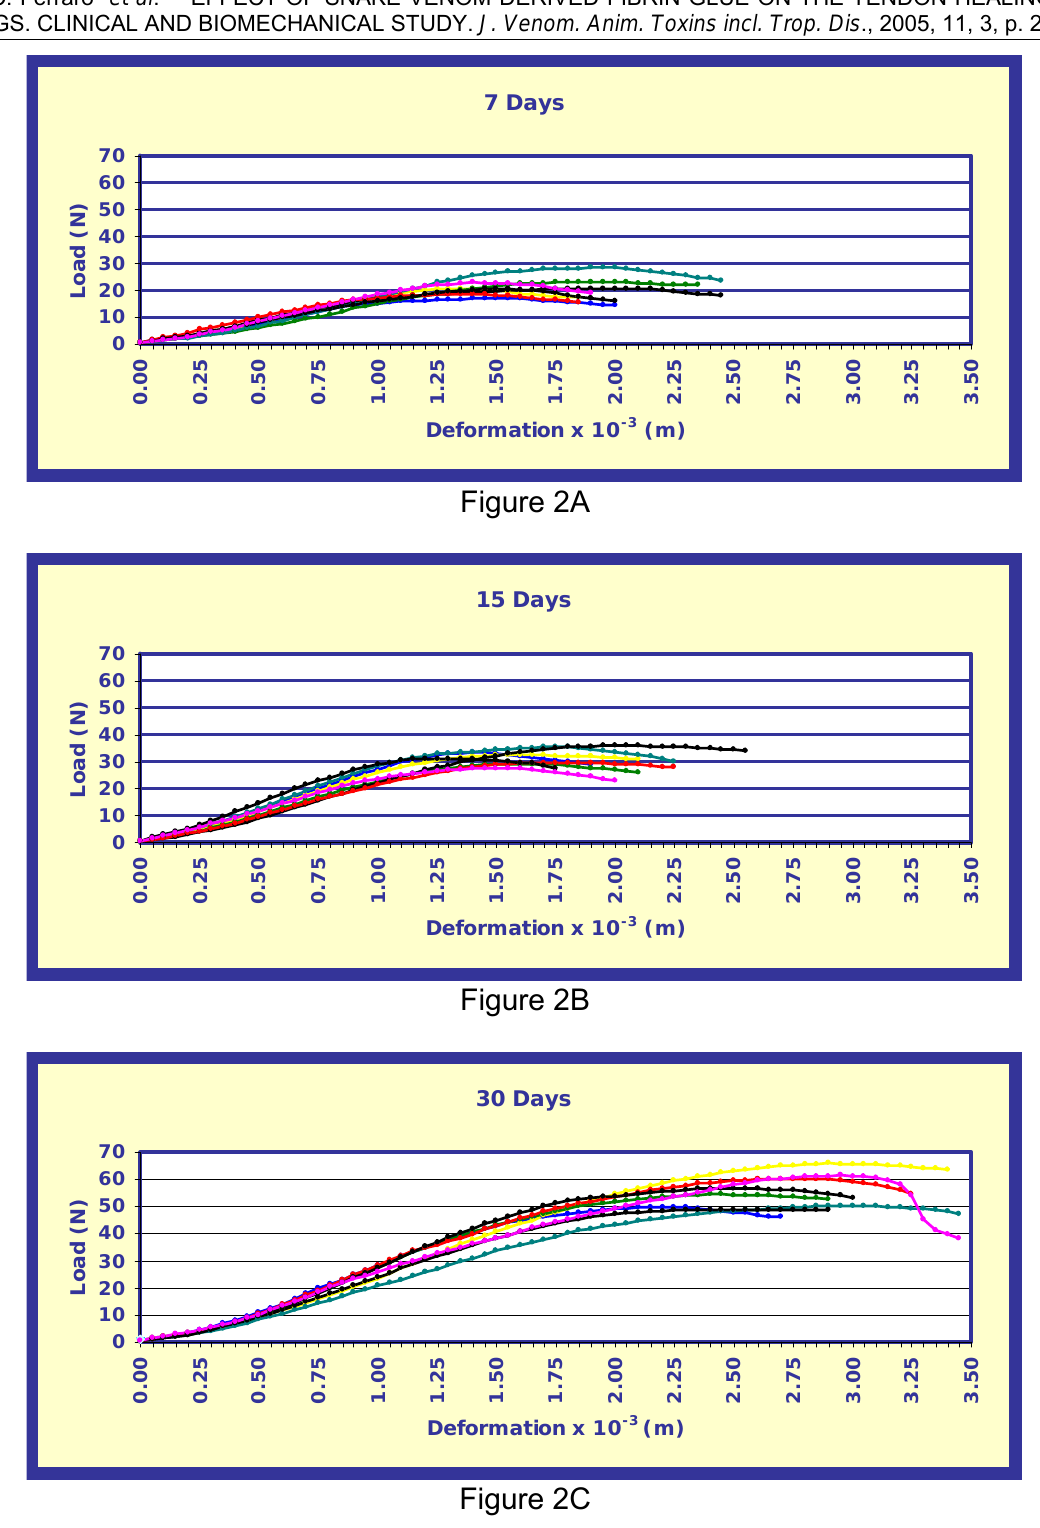
Figure 2: Load x deformation curves of traction tests of the deep digital flexor tendon segments of dog thoracic limb using snake venom derived glue on the 7 th (A), 15 th (B) and 30 th (C) day of